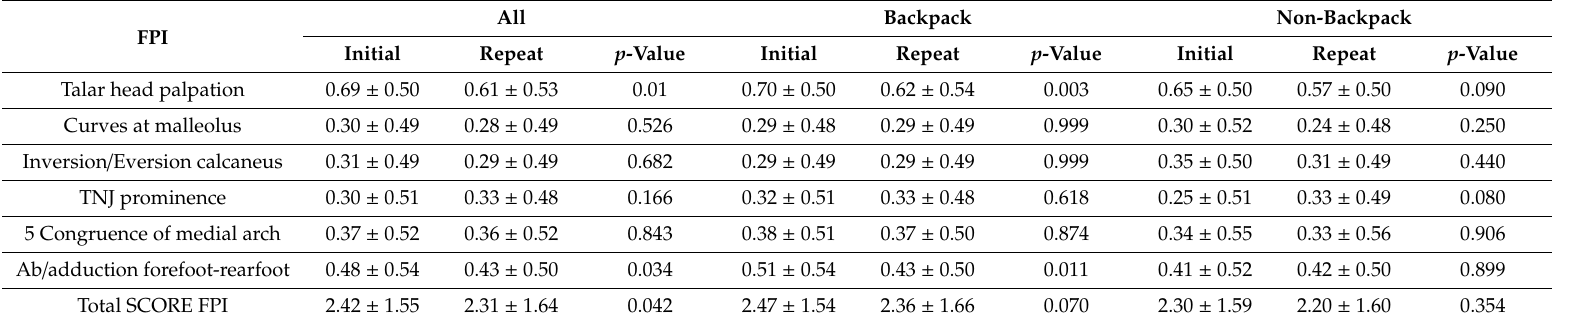
Table 2. Di ff erences between the total FPI scores and those for the six index criteria according to backpack use. All FPI